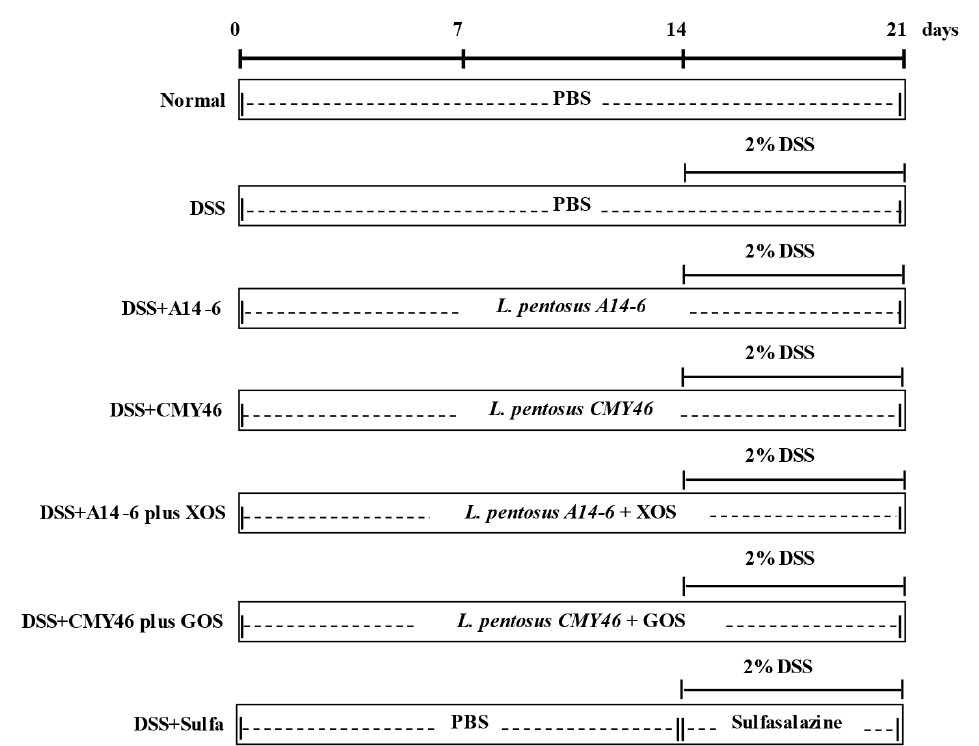
Figure 1. Schematic experimental protocol for investigating the protective effect of probiotics and synbiotics from Miang on experimental colitis in mice. DSS, dextran sulfate sodium; XOS, xylooligosaccharides; GOS, galactooligosaccharides; sulfa, sulfasalazine. PBS, phosphate-buffered saline.